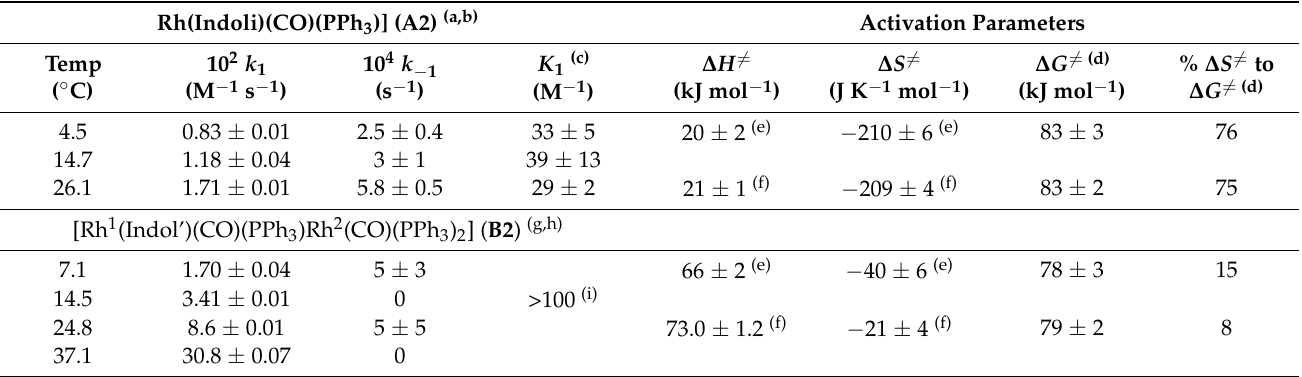
(a) Figure 8; (b) Figure 6; (c) Equation (2), assuming the intercept = k − Supplementary Materials: Figures S18 and S19; (f) Global fit of all k obs vs. T vs. [MeI] data [23,44]; (g) Figure 9; (h) Figure 8; (i) Estimated based on large esd’s of